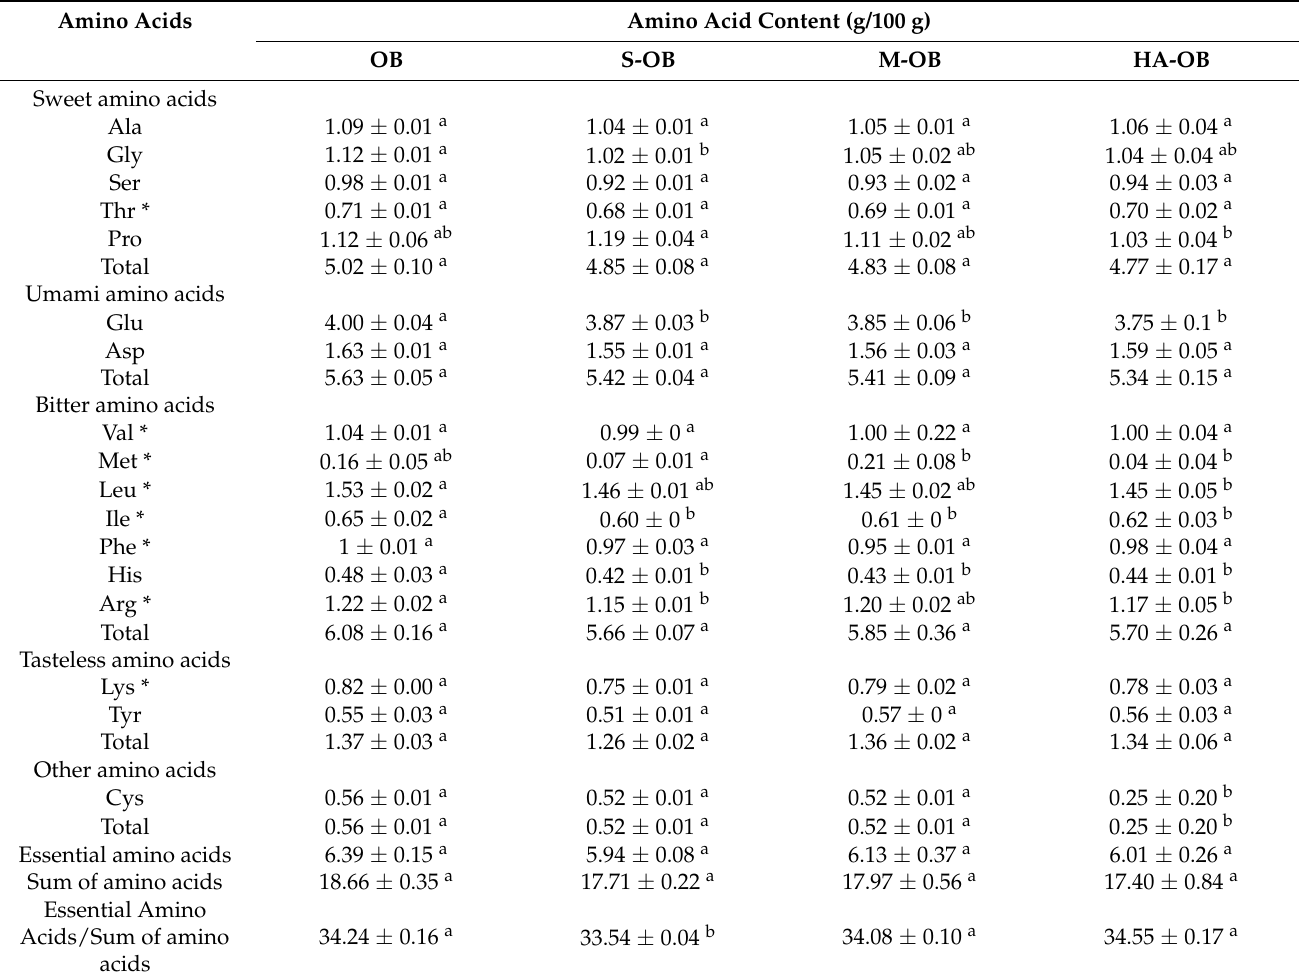
Table 3. Contents and composition of amino acids and in oat